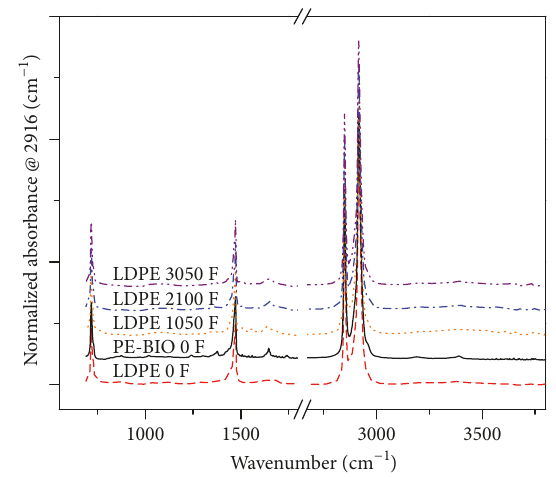
Figure 1: IR spectrum of LDPE and PE-BIO films exposed to CO 2 laser